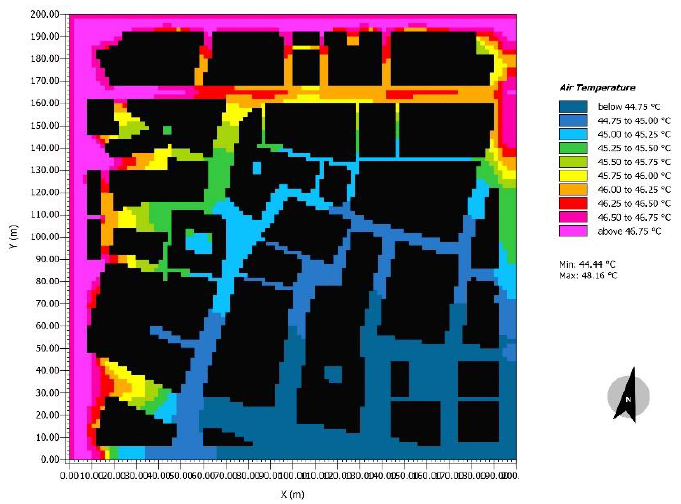
Figure 17. Air temperature for Al Fahidi urban form at 2:00 p.m. on 15 August. (ENVI-met). The average wind speed was 5.15 m/s, which is an increase of 1.55 m/s from the